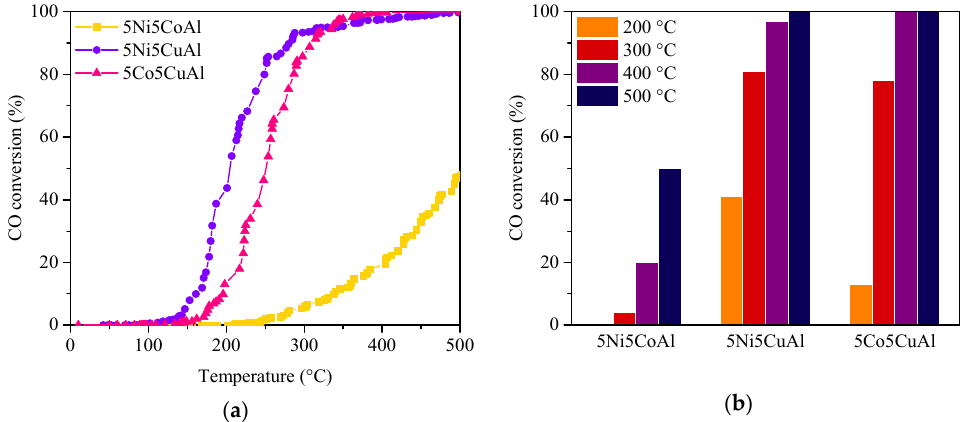
Figure 9. ( a ) CO conversion under transient and ( b ) steady-state conditions over the 5M5MAl catalyst samples. Table 3. Light-o ff , T 50 and T 100 temperatures of the 5M5MAl catalyst samples. Sample